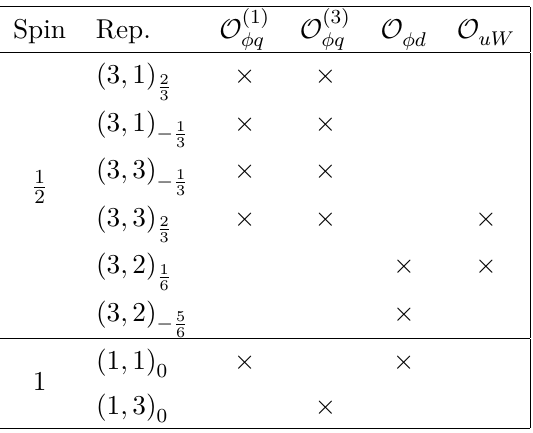
Figure 5 . The maximal NP scale Λ for (cid:2) (cid:3) M ij / (∆ M ij ) exp for B s (blue), B d (red) and K 0 (green), respectively. 2 12 BSM